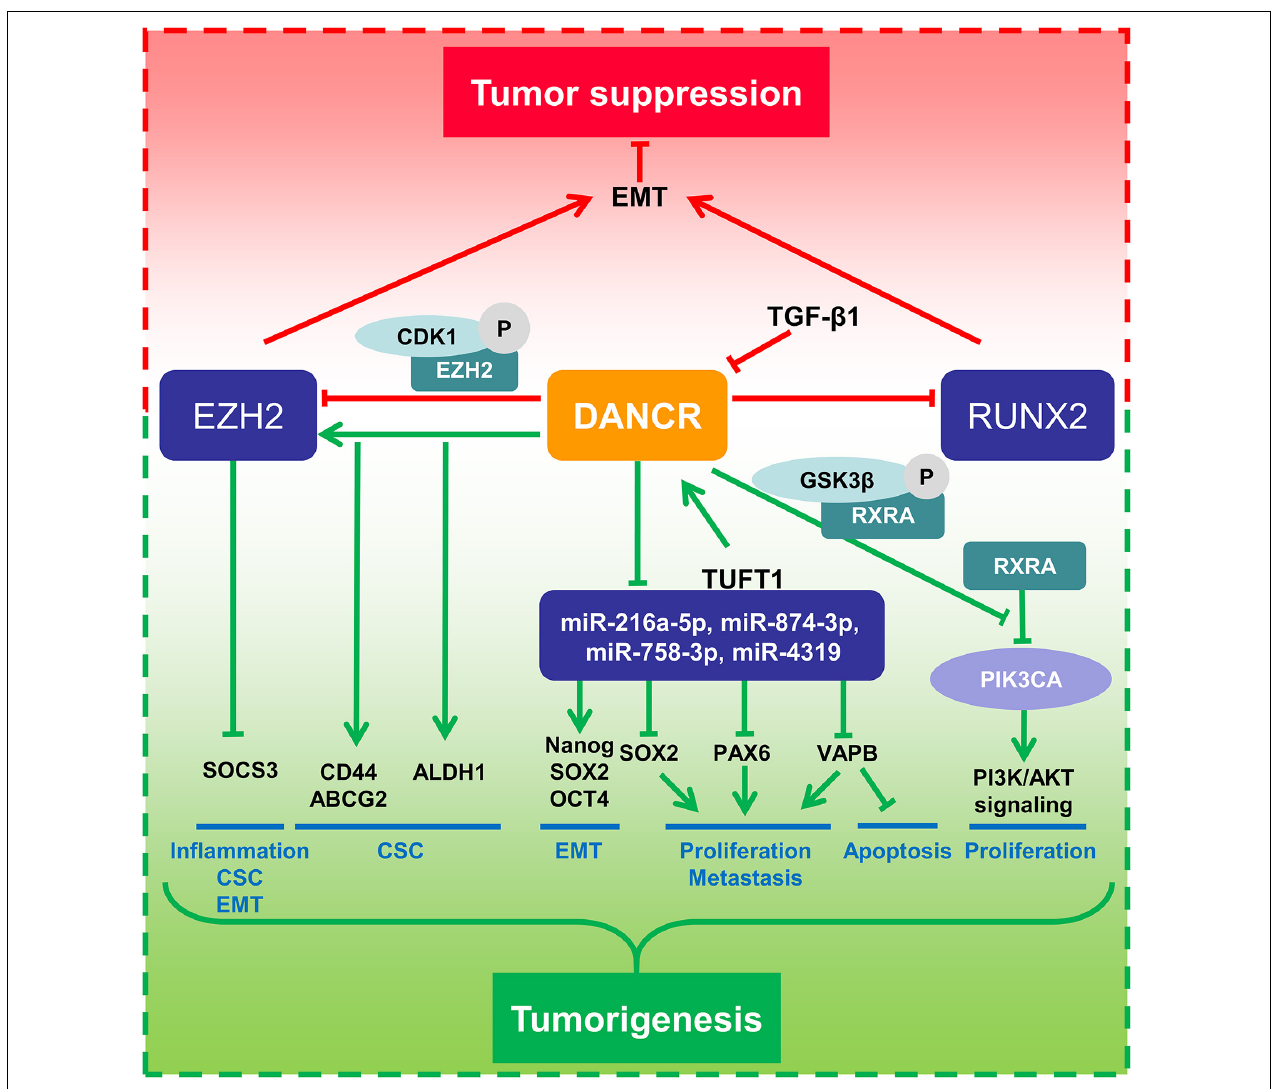
FIGURE 5 | Mechanism of DANCR in breast